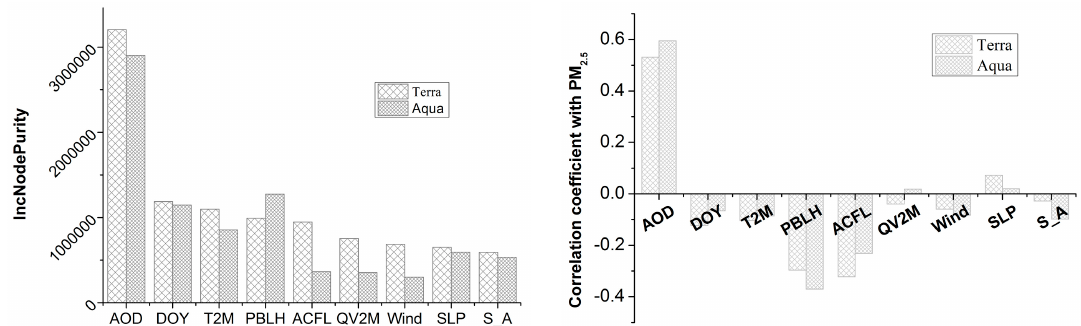
Figure 3. The importance of RF variables ( left ) and the correlation coefficients between variables and PM 2.5 concentration ( right ).